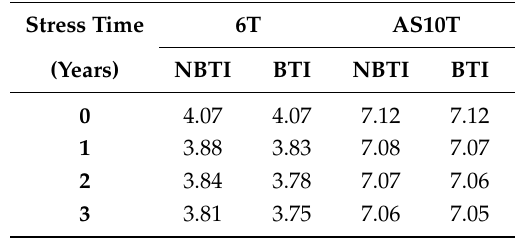
Table 3. Critical charge (fC) at the sensitive node of the respective SRAM cells with and without BTI after three year of stress time. For BTI both, NBTI/PMOS and PBTI/NMOS occurring in transistors, are considered.